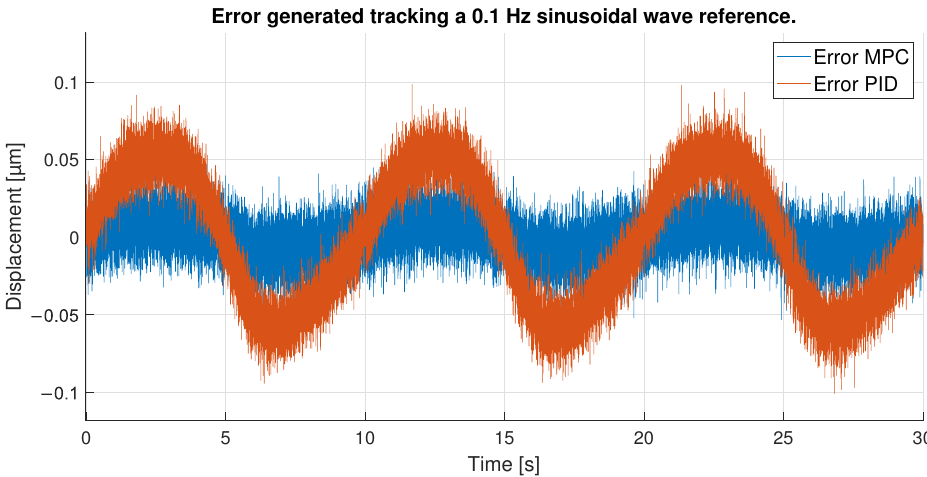
Figure 16. Error of tracking of the PID and MPC for a 0.1 Hz sinusoidal